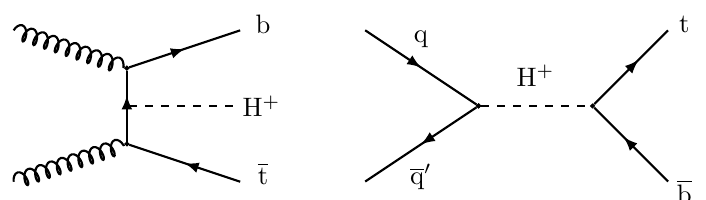
Figure 1 . The LO diagrams for production of a heavy charged Higgs boson, showing the production with a top and a bottom quark (4FS) (left) and via an s -channel process (right). Higgs bosons can appear at or below the TeV scale [15]. At tree level, the production and decay of the H (cid:6) depends on its mass ( m (cid:6) ) and the ratio of the vacuum expectation H values of the neutral components of the two Higgs doublets (tan (cid:12)